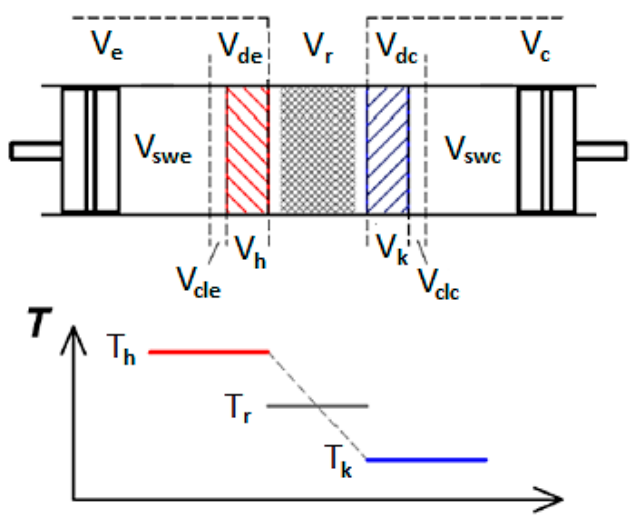
Figure 2. Schmidt analysis, adapted from [12].